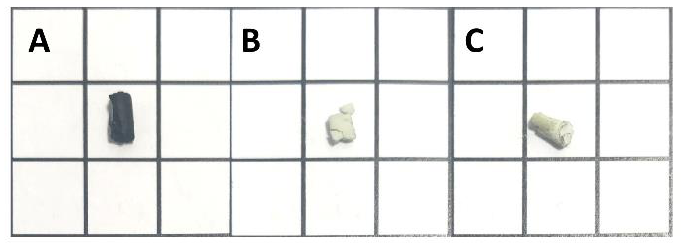
Figure 9. Photographs of the carbonized hybrid gels TS 0 . 15_6_10_c ( A ), TS 0 . 5_6_10_c ( B ), TS 1 . 0_6_10_c ( C ), illustrated on a 1 cm 2 grid.